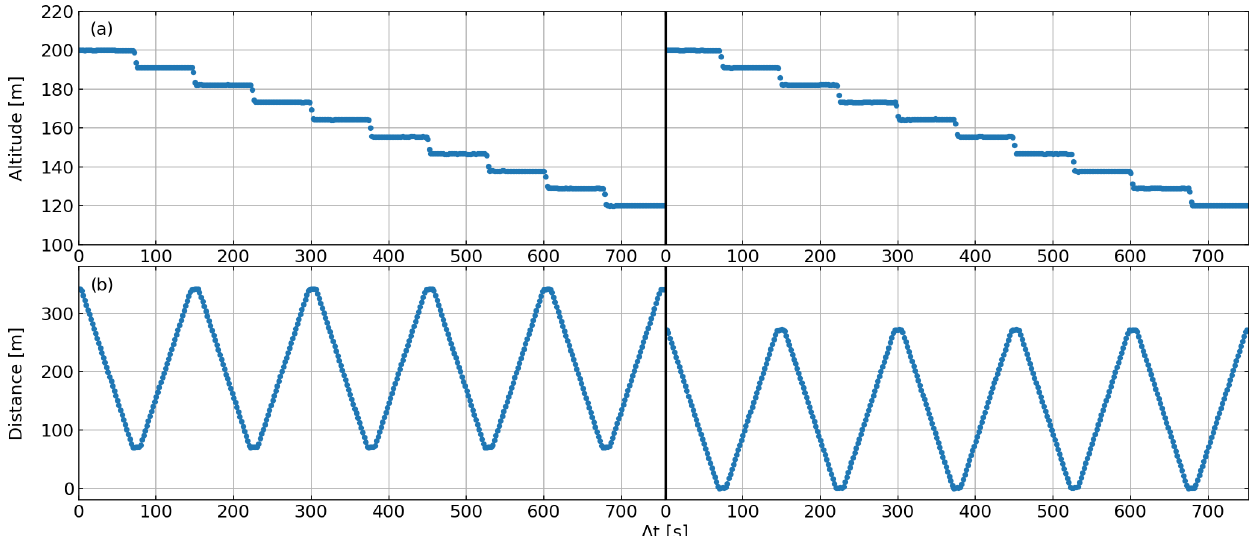
Figure A2. Detailed flight pattern of two flights downwind of the ExxonMobil natural gas processing facility in Großenkneten 40km west of Bremen, Germany, 10 April 2020. (a) Altitude. (b) Horizontal distance from the west-most point of the flight pattern. Left: flight 1. Right: flight